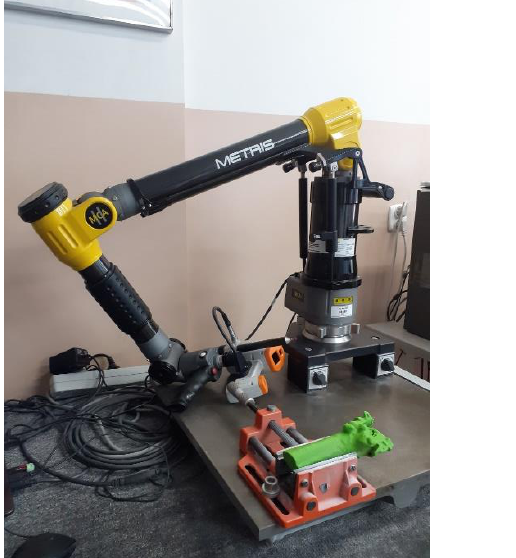
Table 4. Parameters of the MFR test.